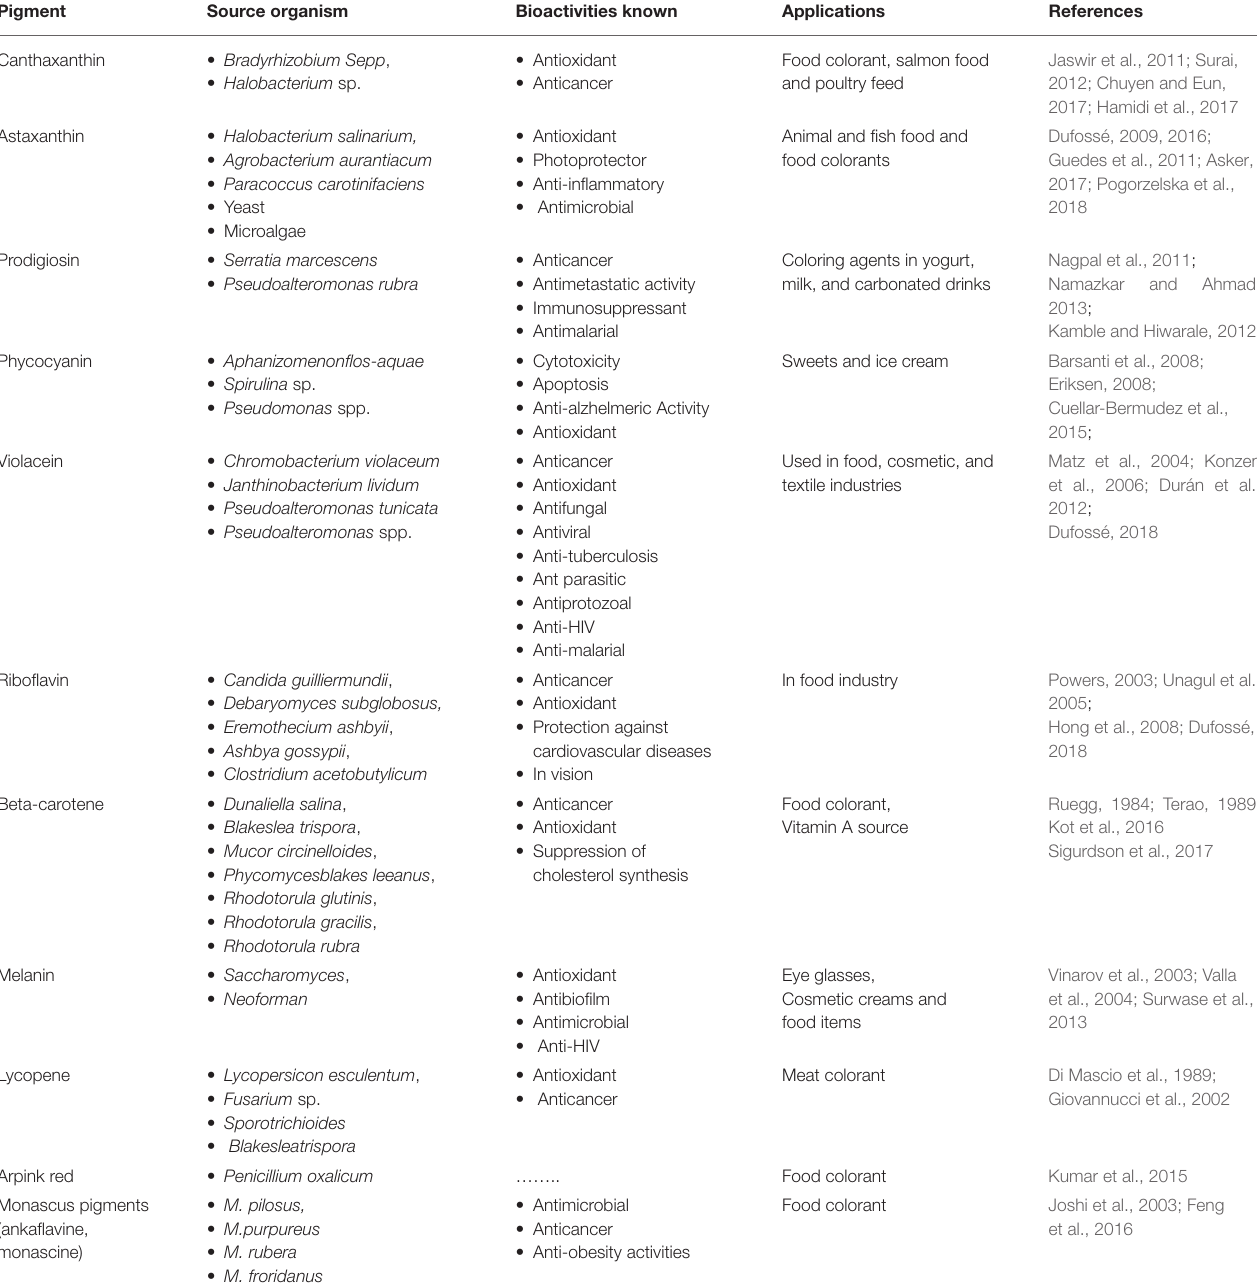
TABLE 2 | Microbial sources, bioactivity and applications of natural